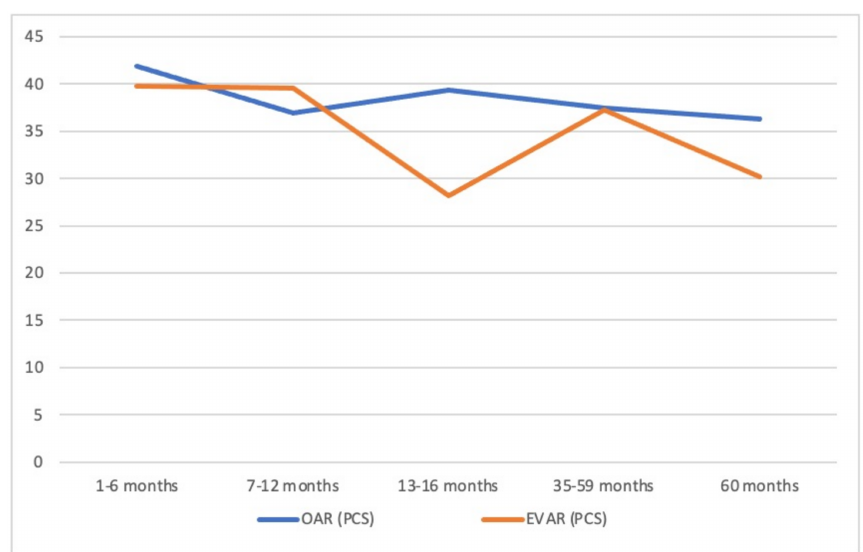
Figure 1. PCS scores according to the time elapsed from the intervention to the completion of the questionnaire for patients treated with OAR and EVAR (comparison at 60 months: p < 0.040). Sum of the physical component (PCS), open abdominal repair (OAR), endoprosthesis abdominal repair (EVAR).